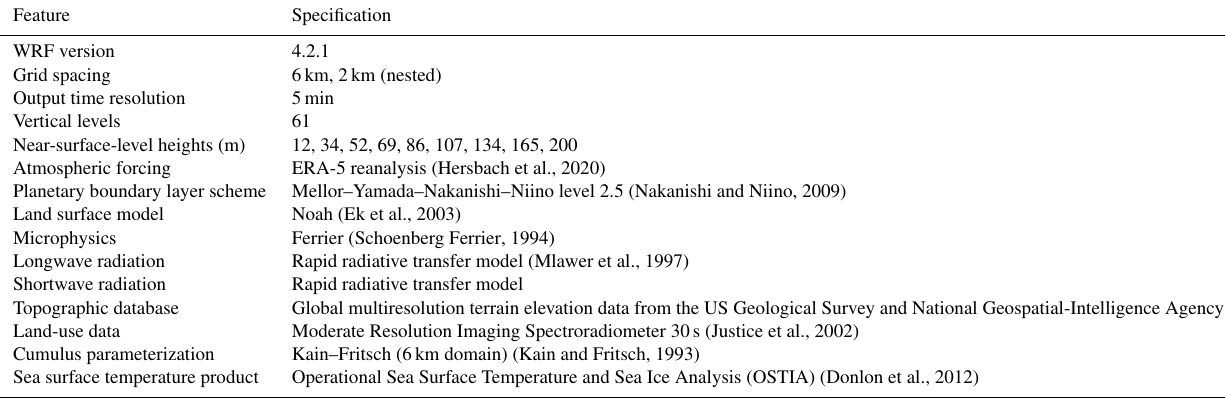
Table 1. Key attributes of the 21-year WRF simulations used in this study.